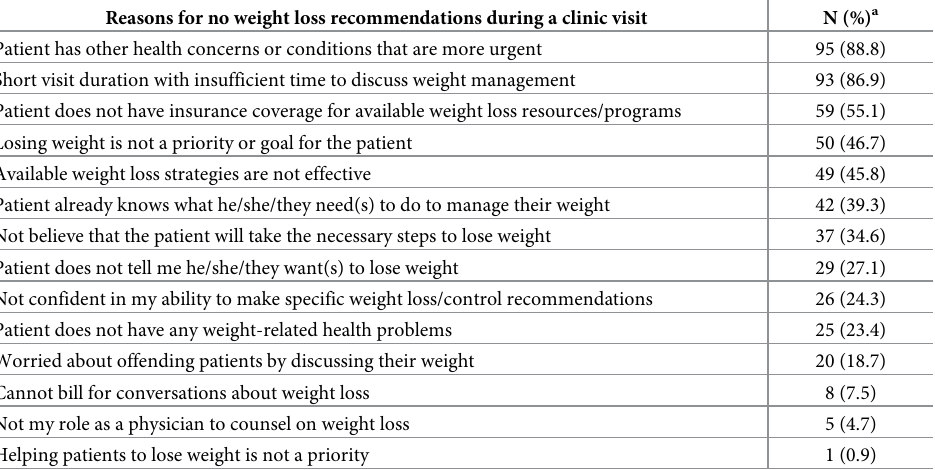
Table 2. Barriers to obesity treatment in primary care settings (N =